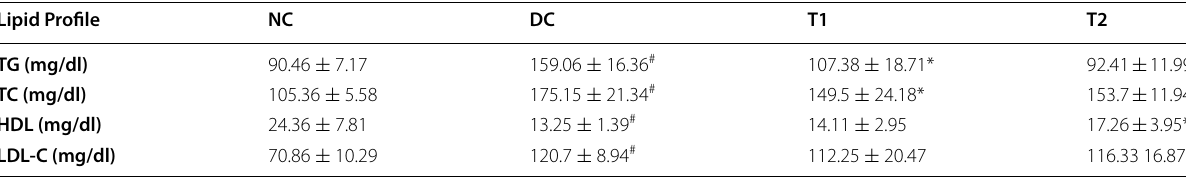
Values are expressed as mean SD ( n 6). # Significantly ( p < 0.05) different from Normal Control. * Significantly ( P < 0.05) different from Disease Control. Statistical ± = analysis was performed by applying one-way ANOVA followed by Dunnet’s Test using Graph Pad Prism V6.0. Statistical significance was kept at P < 0.05 NC Normal control, DC Disease control, T1 Probiotic fermented milk with WPC and SPI, T2 Probiotic fermented milk without WPC and SPI) TG Triglyceride level, TC Total cholesterol, HDL High-density lipoprotein, and LDL-C low-density lipoprotein- cholesterol